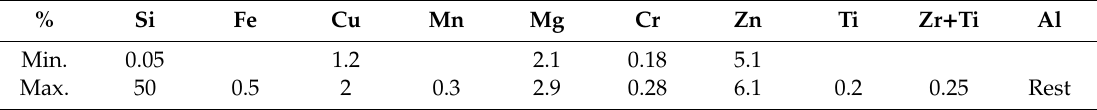
Table 1. Chemical composition of Al 7075T6 [13].